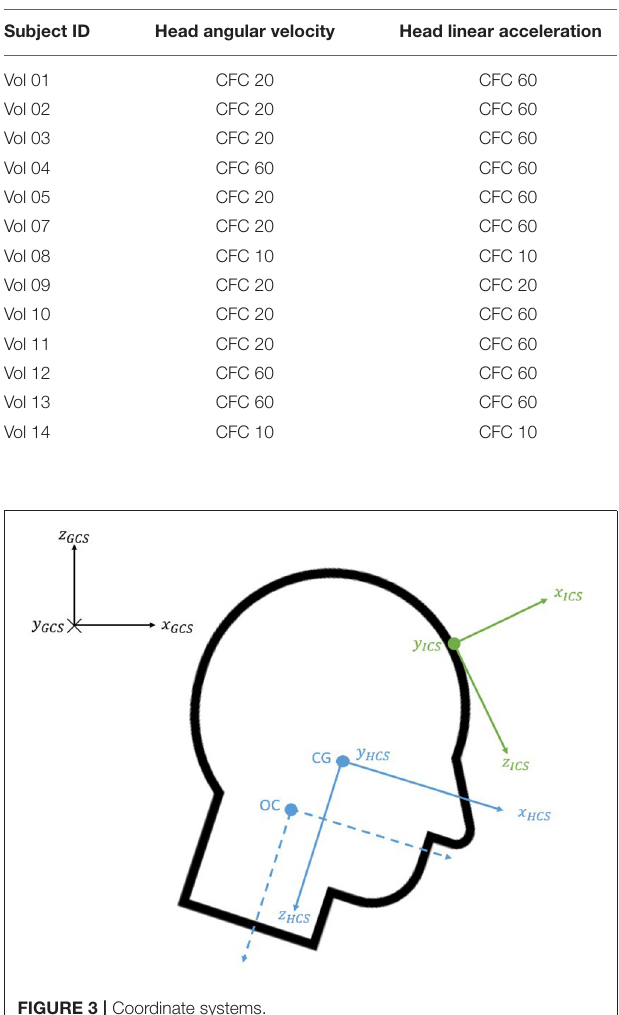
FIGURE 3 | Coordinate systems.